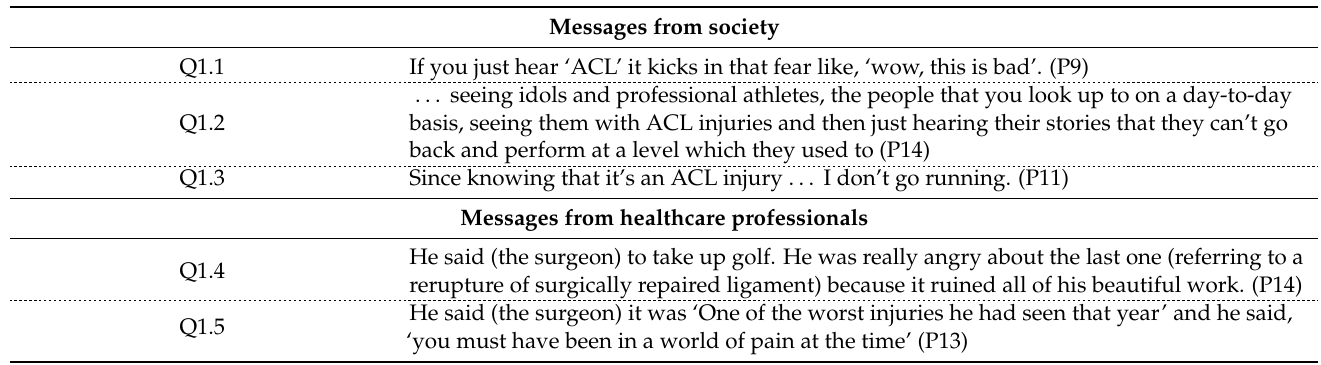
Table 2. Supporting quotes to theme 1—external messages driving fear.